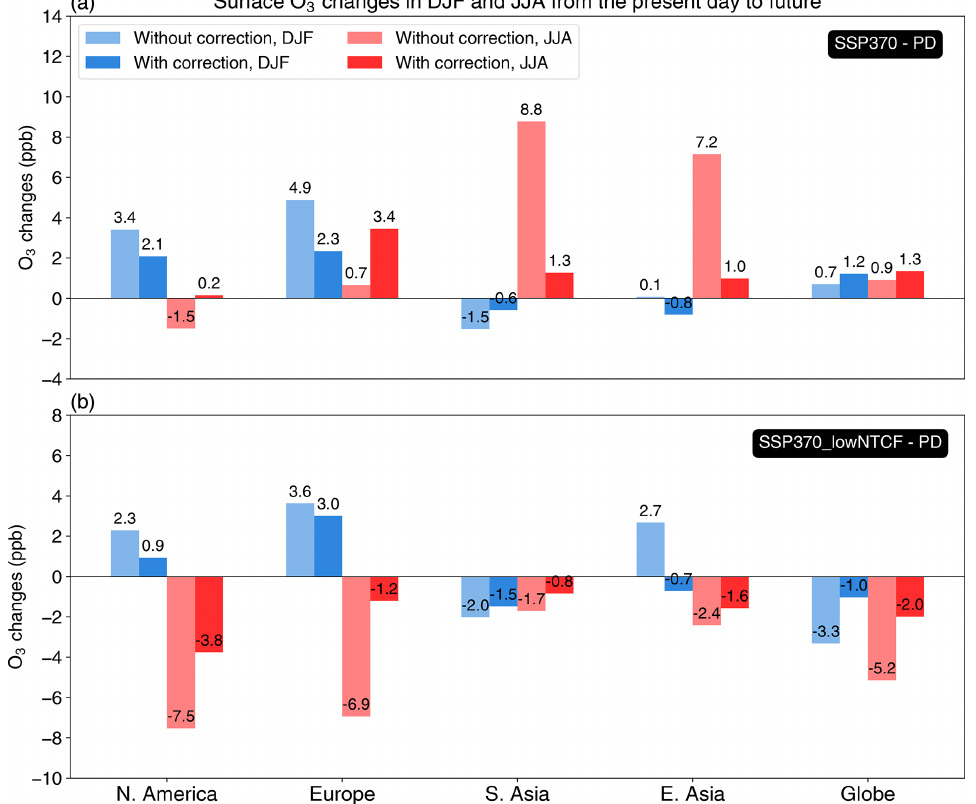
Figure 9. Changes in seasonal mean surface O 3 mixing ratios (ppb) with and without corrections in DJF (blue bars) and JJA (red bars) from the present day (PD) to (a) SSP3-7.0 and (b) SSP3-7.0-lowNTCF in North America, Europe, South Asia, East Asia and the